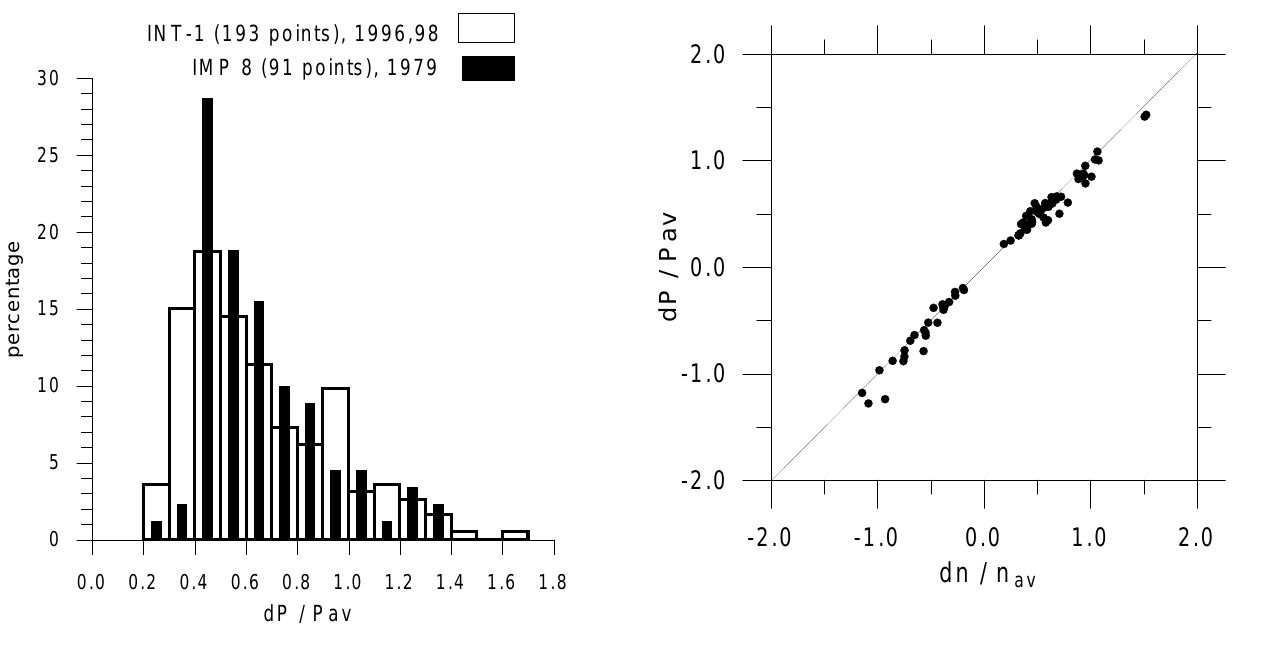
Fig. 3. Distributions of relative pressure changes. Fig. 4. The dependence of the magnitude of the relative pressure changes on the magnitude of the relative density